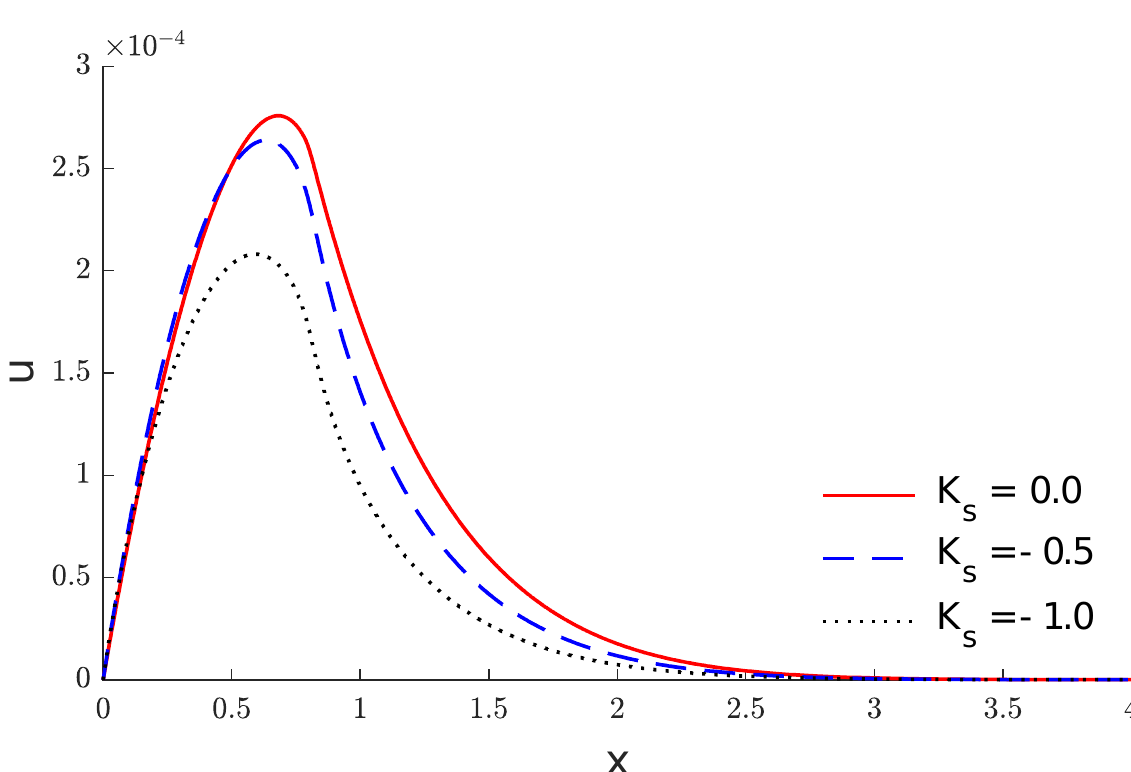
Figure 2. The displacement variations under various values of 𝐾 𝑠 .